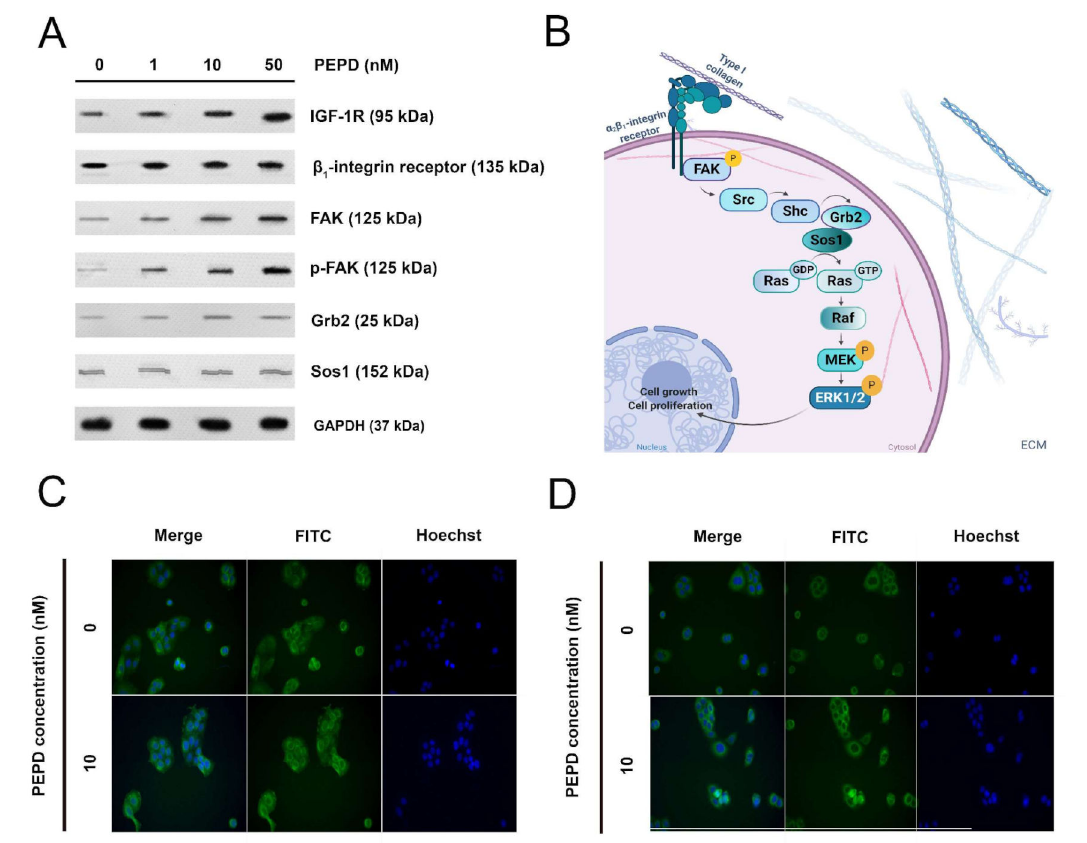
Figure 7. Prolidase stimulates expression of the β 1 -integrin receptor, IGF-1R, and EGFR signaling proteins. ( A ) The proteins of the β 1 -integrin receptor, IGF-1R, and EGFR-downstream signaling pathways were analyzed by Western immunoblotting in lysates of PEPD-stimulated HaCaT cells for 30 min and 24 h. Representative blot images are shown (densitometric analysis of presented protein is included in Supplementary Materials (Supplementary Figure S8)). ( B ) The scheme for activation of the β 1 -integrin receptor-downstream signaling pathway. Created with BioRender.com. ( C ) Immunostaining of EGFR in PEPD-stimulated HaCaT cells for 24 h. ( D ) Immunostaining of FAK in PEPD-stimulated HaCaT cells for 24 h (magnification 200 ×